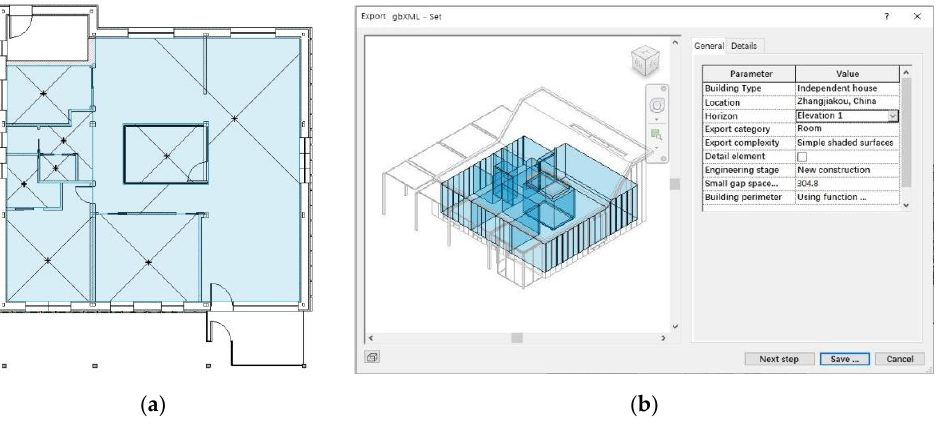
Figure 23. BIM space model export. ( a ) Room division; ( b ) exporting in GBXML format.